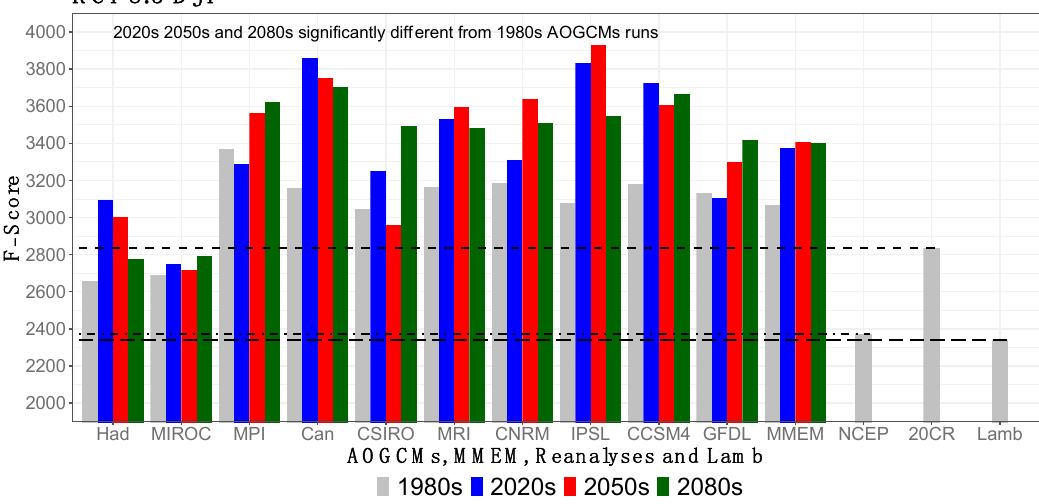
Figure 6. F-Score for LWTs associated with concurrent fluvial flooding-wind hazards during winter (DJF). The F-Score is shown for each AOGCM, MMEM, NCEP, 20CR and Lamb’s subjective catalogue for the 1980s, 2020s, 2050s and 2080s periods. The LWTs used for calculating the F-Score are associated with concurrent multi-basin fluvial flooding and wind hazards within Great Britain (GB) [25]. The 1980s MME F-Score were estimated from the mean of n = 1,000 boot-strapped samples and all the future 2020s, 2050s and 2080s periods are significantly different from these, as the F-Score of the latter fall outside the 95% confidence intervals of the 1980s means. The AOGCMs 1980s confidence intervals bars are not shown for simplicity because they are vanishingly narrow. Dashed lines represent the reanalyses and Lamb’s catalogue values.